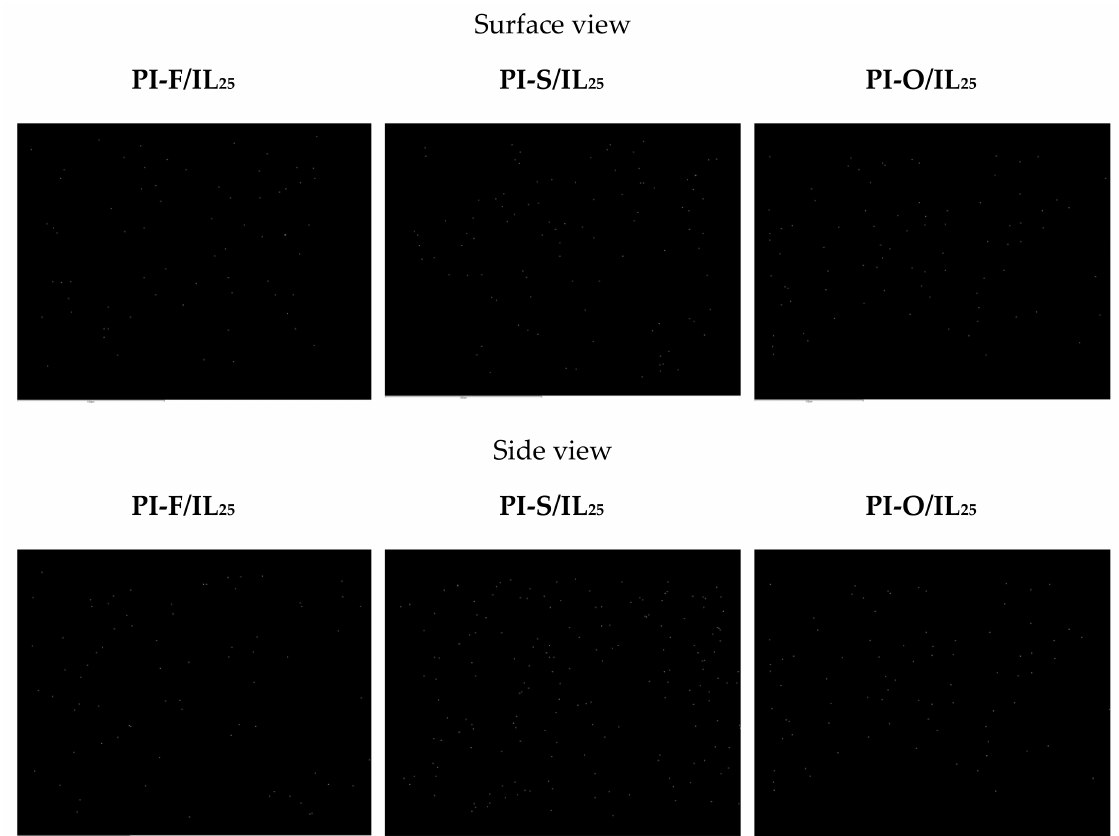
Figure 6. The bright spots in each picture confirm the presence of bromine evenly distributed on the surface and across the film.